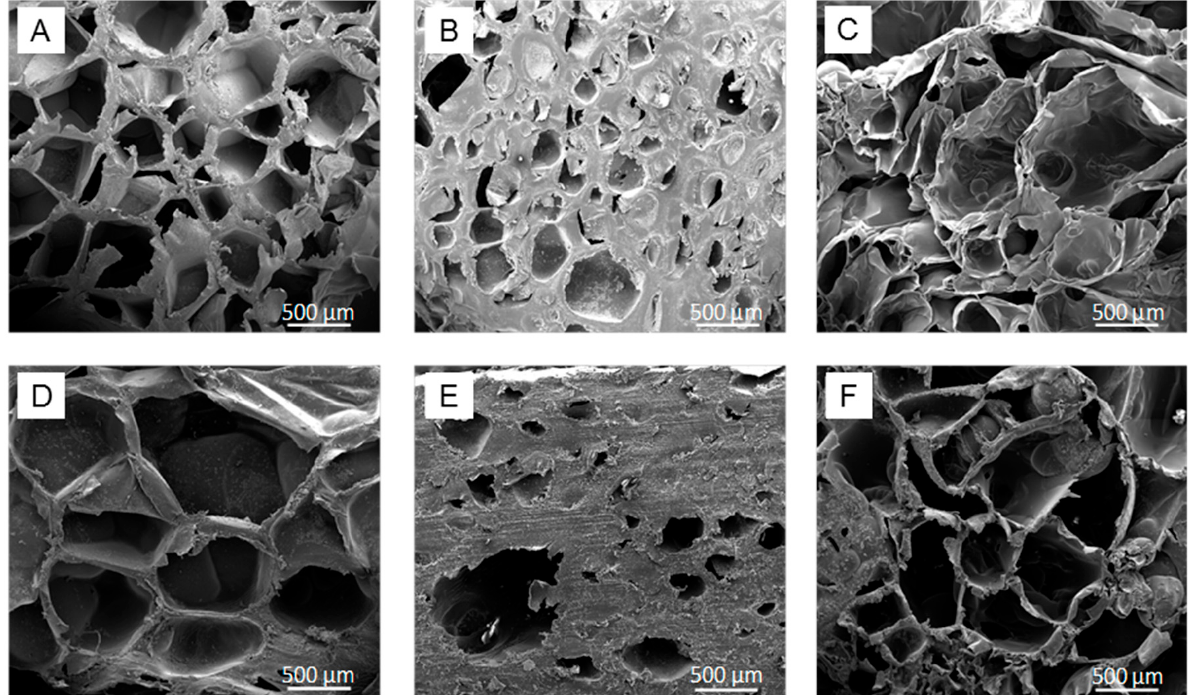
Figure 3. SEM images corresponding to longitudinal ( A – C ) and cross-sections ( D – F ) of ( A , D ) PLA processed with Freon R134a; ( B , E ) PLA processed with scCO 2 ; and ( C , F ) PLGA processed with Freon R134a.